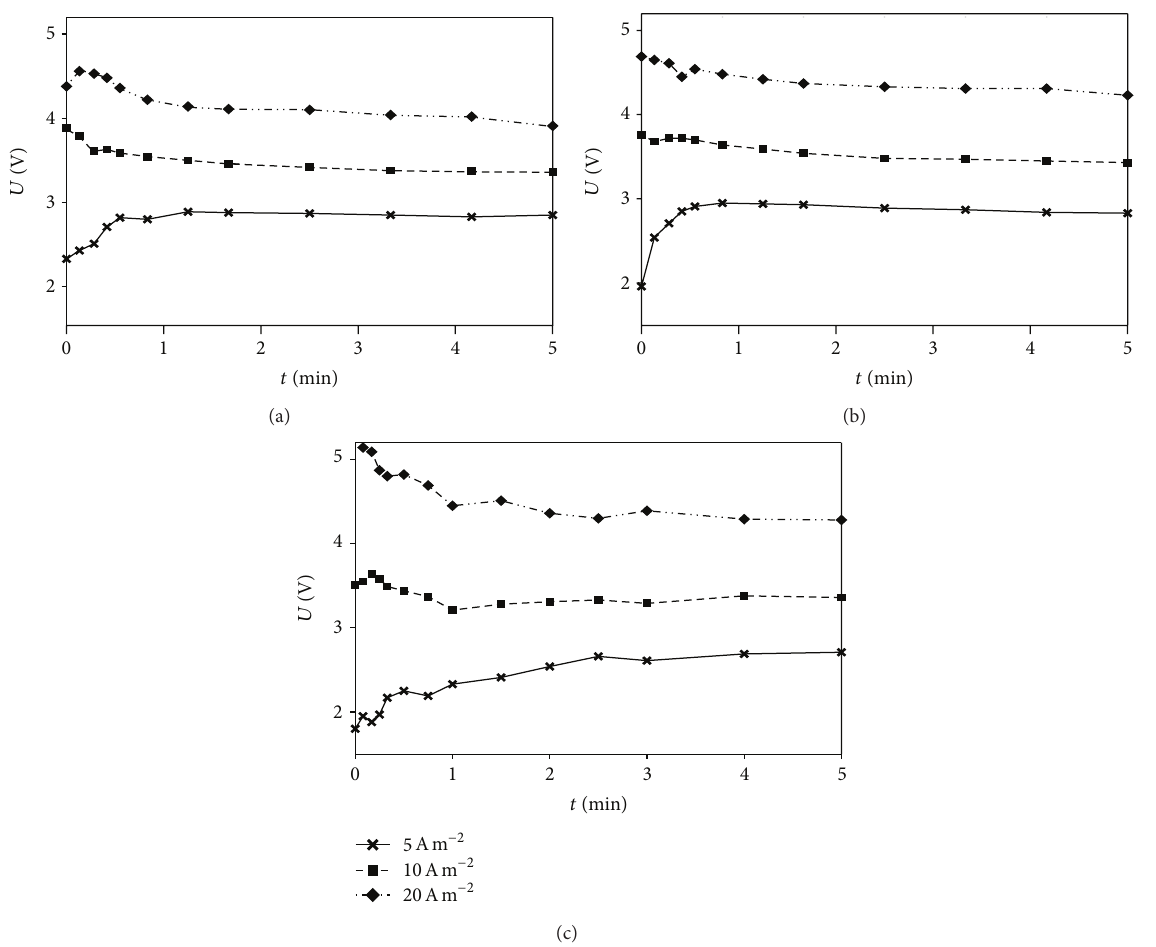
Figure 4: Variation of the potential drop as a function of the EC treatment time during As removal from natural water at different current densities (5–20 Am −2 ) and the feedwater flow rates (a) 0.25, (b) 0.50, and (c) 1.00 Lmin −1 .